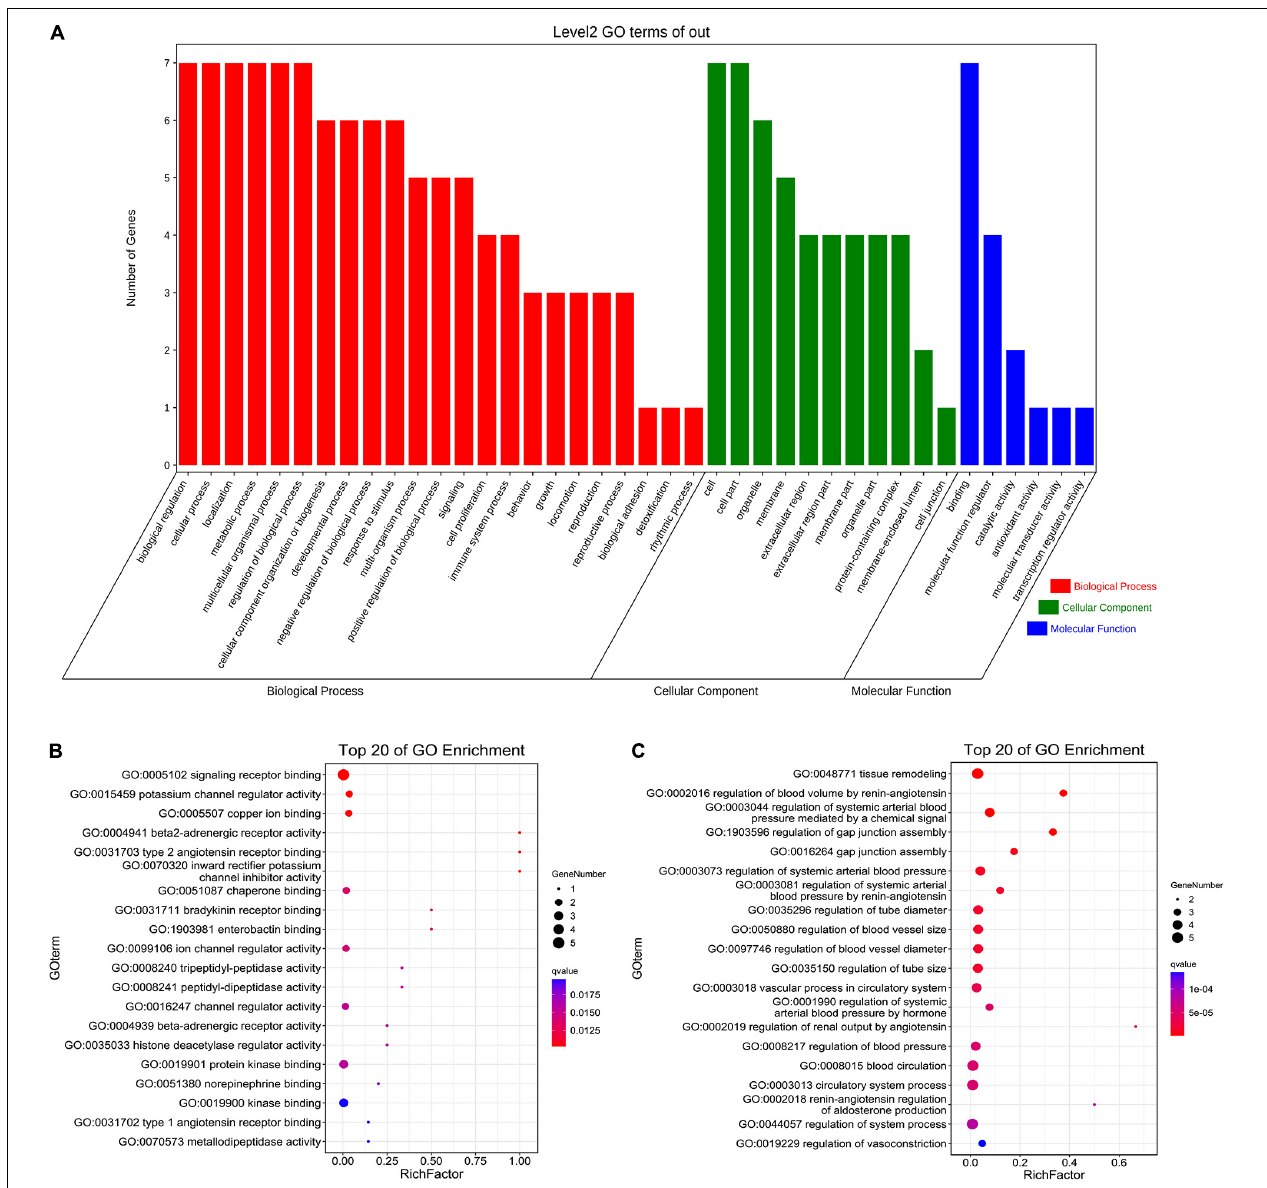
FIGURE 5 | GO enrichment analysis of seven target genes (ACE, CAV1, AGT, REN, ADRB2, TP53, and ALB) for anti-arrhythmias with SV. (A) Biological process, cellular component and molecular function of Go enrichment of the target genes. (B,C) The bubble diagram shows the top 20 enriched molecular function and biological process